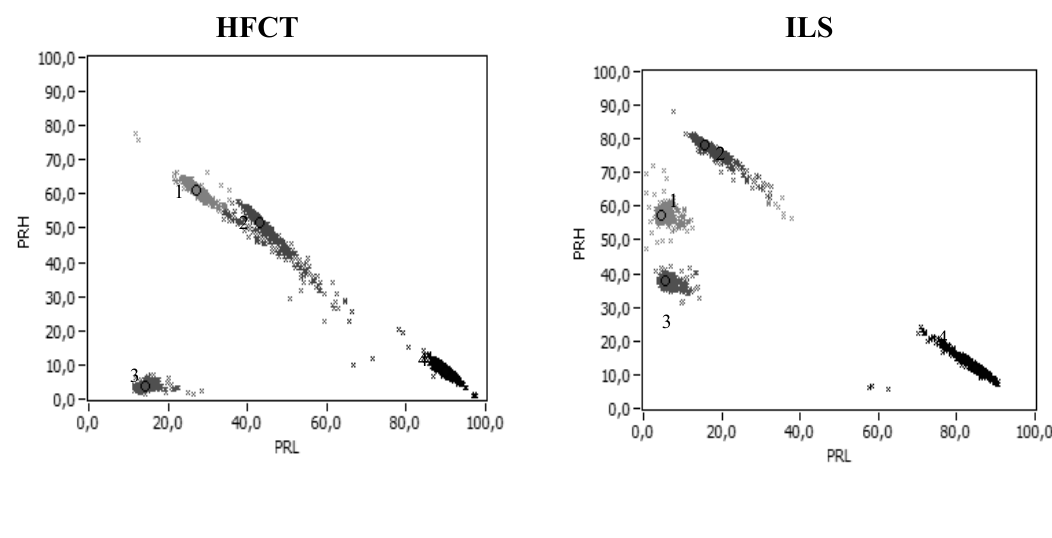
Figure 15. Summary of the relative positions of the HFCT and ILS sensors in the PR maps to f = 10 MHz, f = f = 30 MHz, f = 50 MHz, f = 60 MHz. Surface PD (cluster 1), 1L 2L 1H 2H T Internal PD (cluster 2), Corona PD (cluster 3) and Noise (cluster